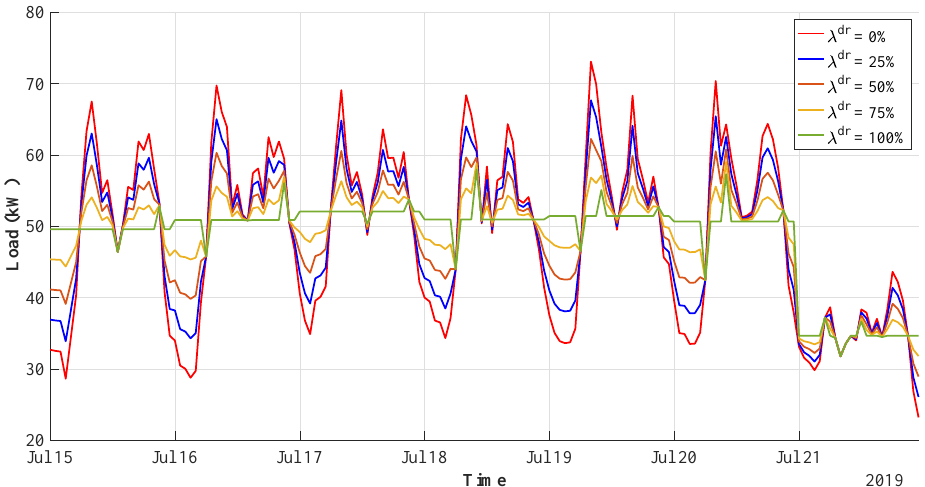
Figure 10. DR for different flexibility